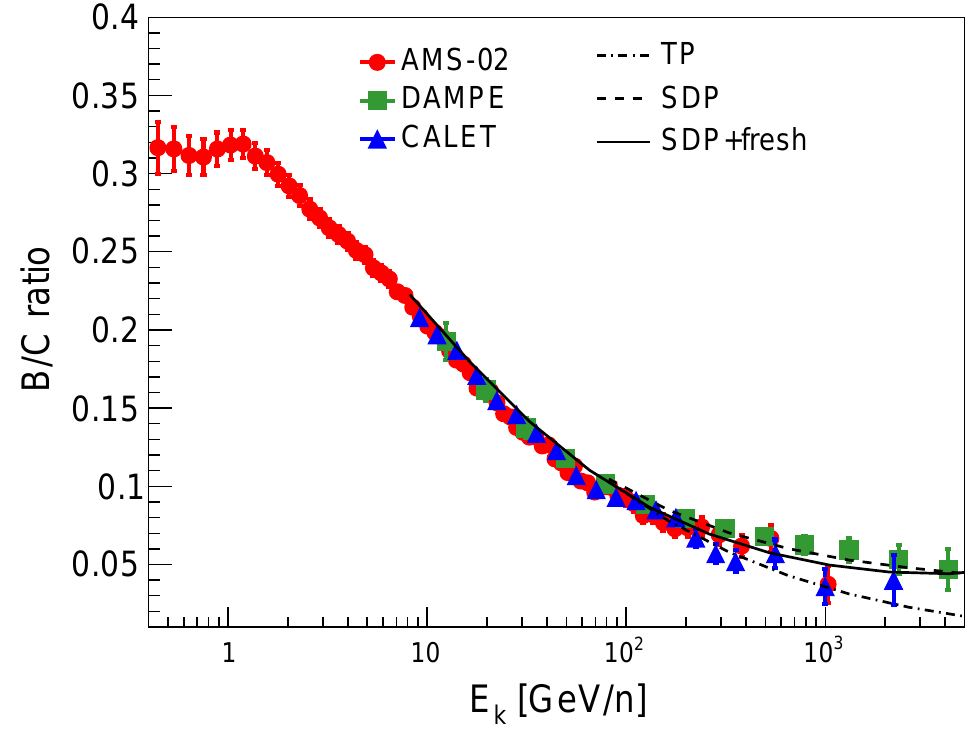
Figure 1. The model calculations of secondary to the primary ratio of B/C from Traditional Propaga- tion (TP), Spatially Dependent Propagation (SDP), and SDP + “fresh” component models, compared to the measurements by AMS-02 [11], DAMPE [33] and CALET